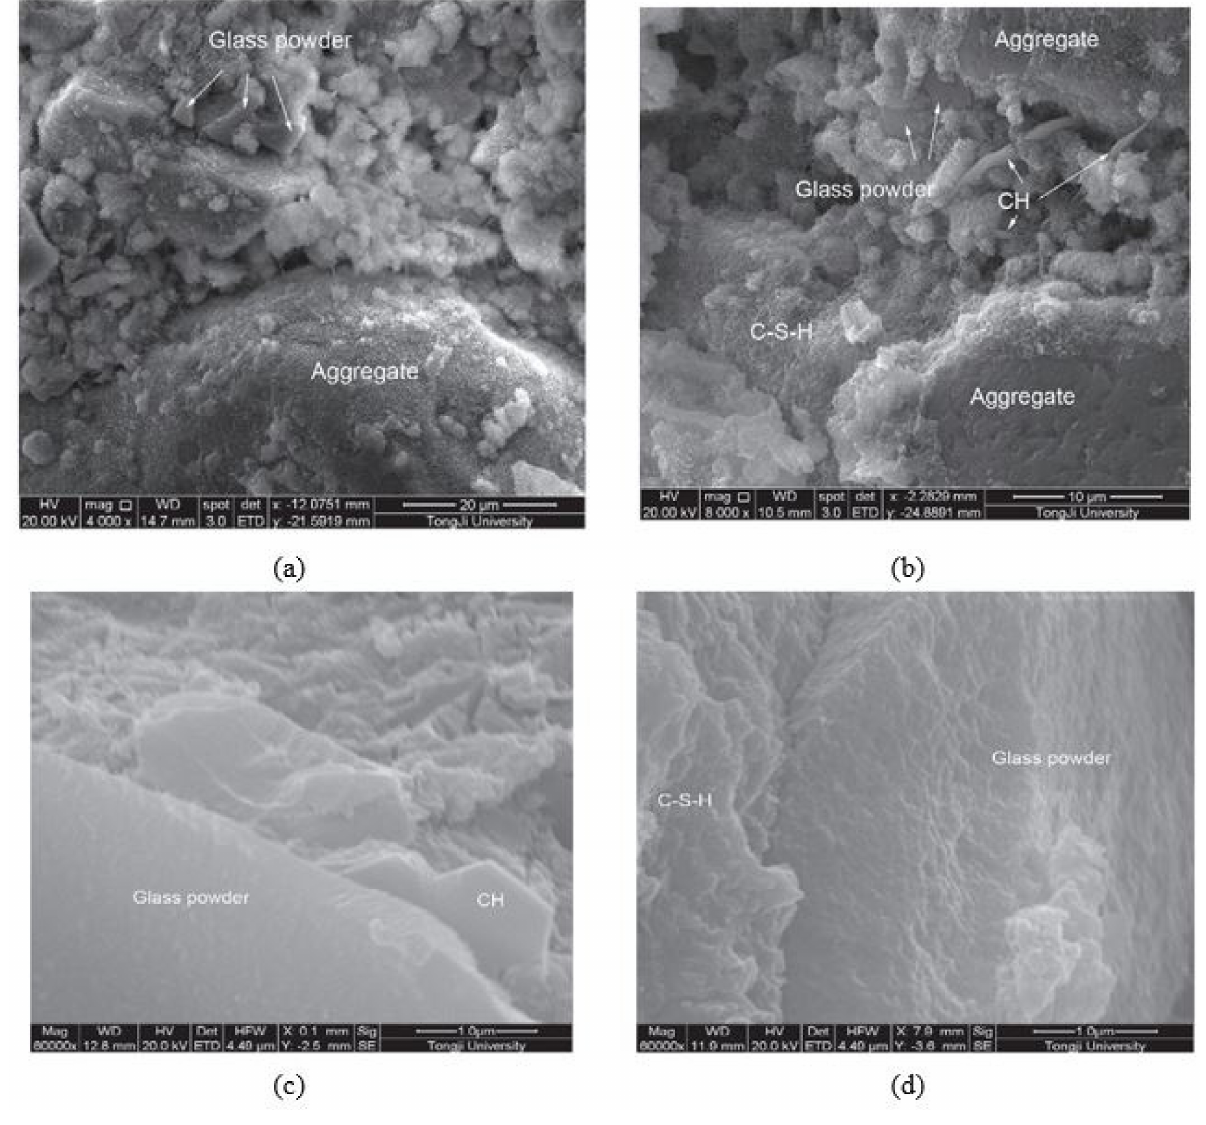
Figure 10. SEM images of the cementitious paste containing WG powder at different ages ( a ) 80 ◦ C at 1 day; ( b ) Microwave curing at 1 day; ( c ) Normal curing at 28 days; ( d ) 80 ◦ C steam curing at 28 days